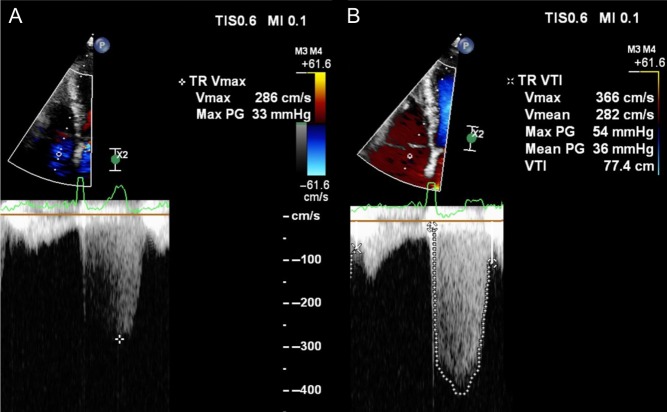
Continuous wave Doppler demonstrating an increase in severity of tricuspid regurgitation and increase in maximal velocity from rest (A) to exercise (B) while cycling at 75 W.